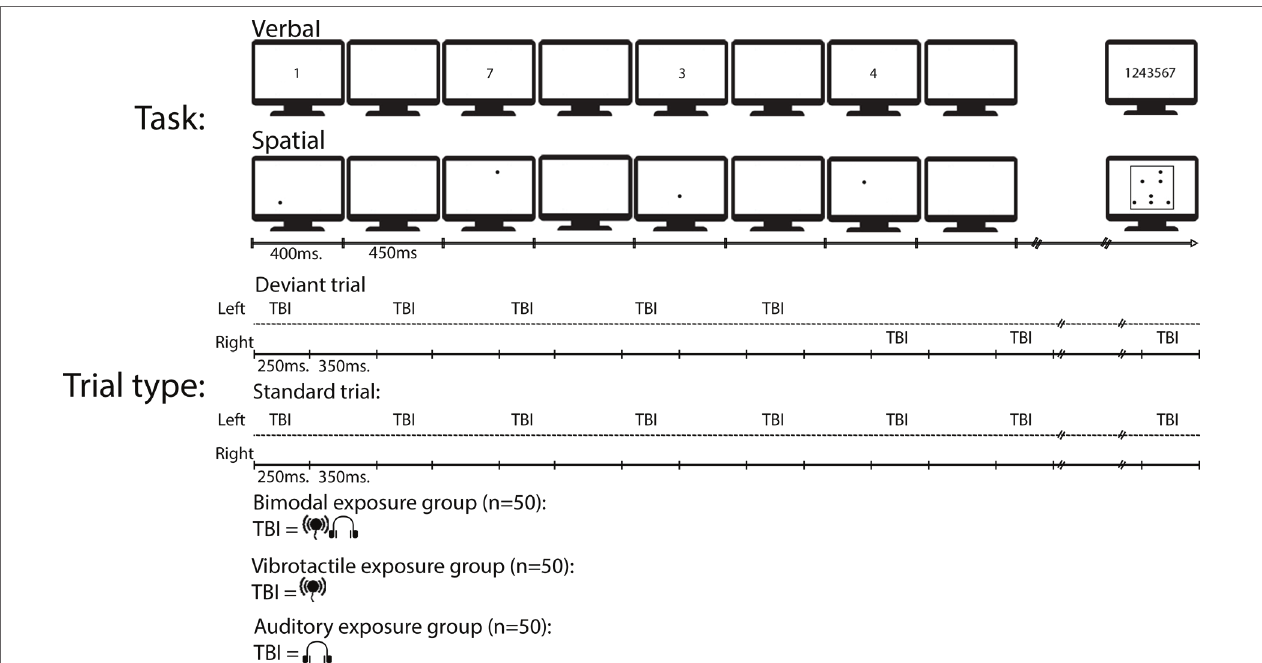
FIGURE 1 | A schematic view of an example deviant and an example standard trial type in the experiment. To-be-ignored (TBI) stimuli were either presented on the same time of the body during an entire trial (i.e., standard) or changed side of the body during deviant trial